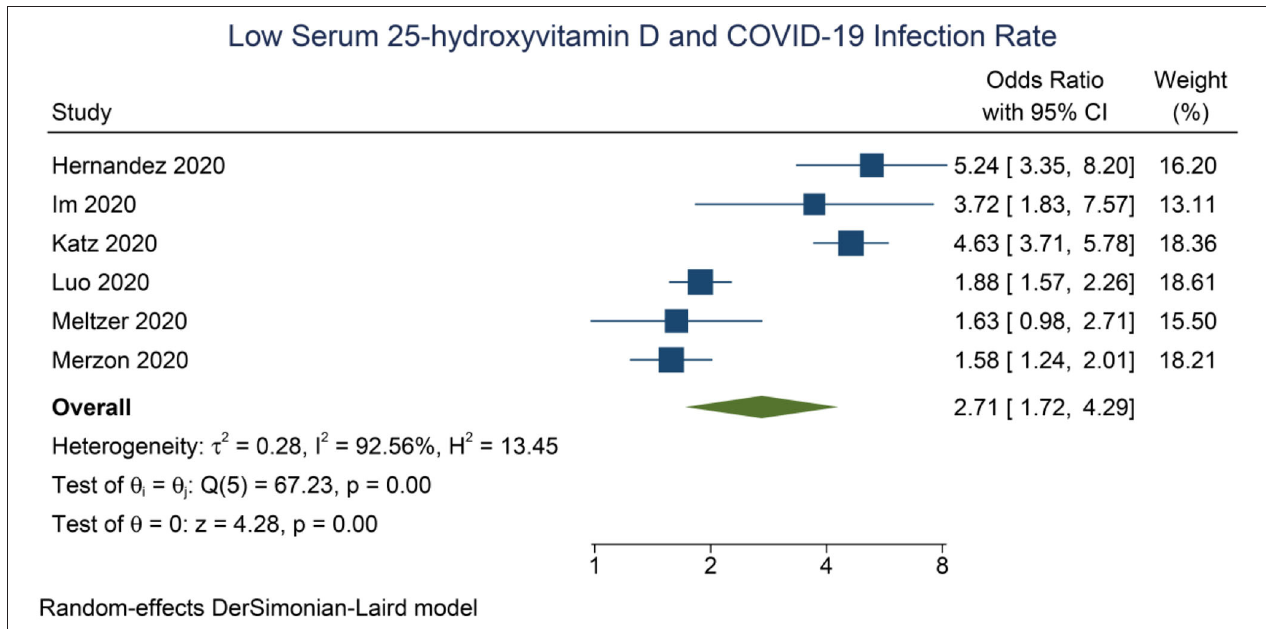
FIGURE 2 | Low Serum 25-hydroxyvitamin D and COVID-19 infection rate.